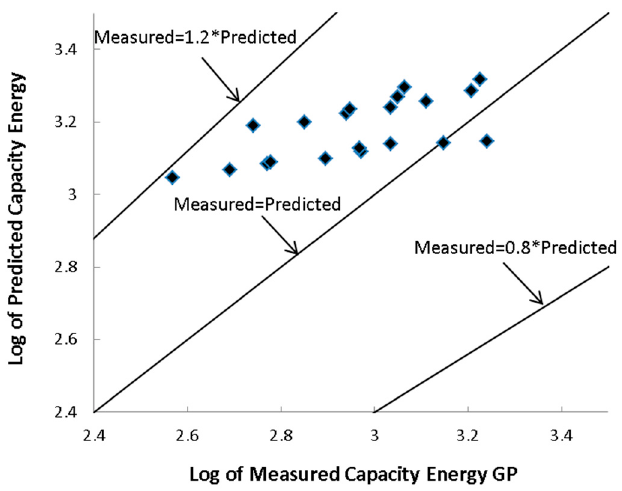
Figure 10. Capacity energy predicted by genetic programming (GP) versus the measured values of laboratory tests.